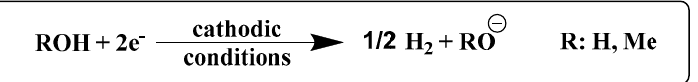
Scheme 1. Electrochemical generation of base from protic media for the electrochemical depolymerization of PET plastic at neutral starting conditions. Table 3. Reactions at room temperature (21 °C), for 1h in a batch electrolysis H-Cell divided by a coarse ceramic frit at controlled potential against a single-junction Ag/AgCl reference electrode with 20 mg PET